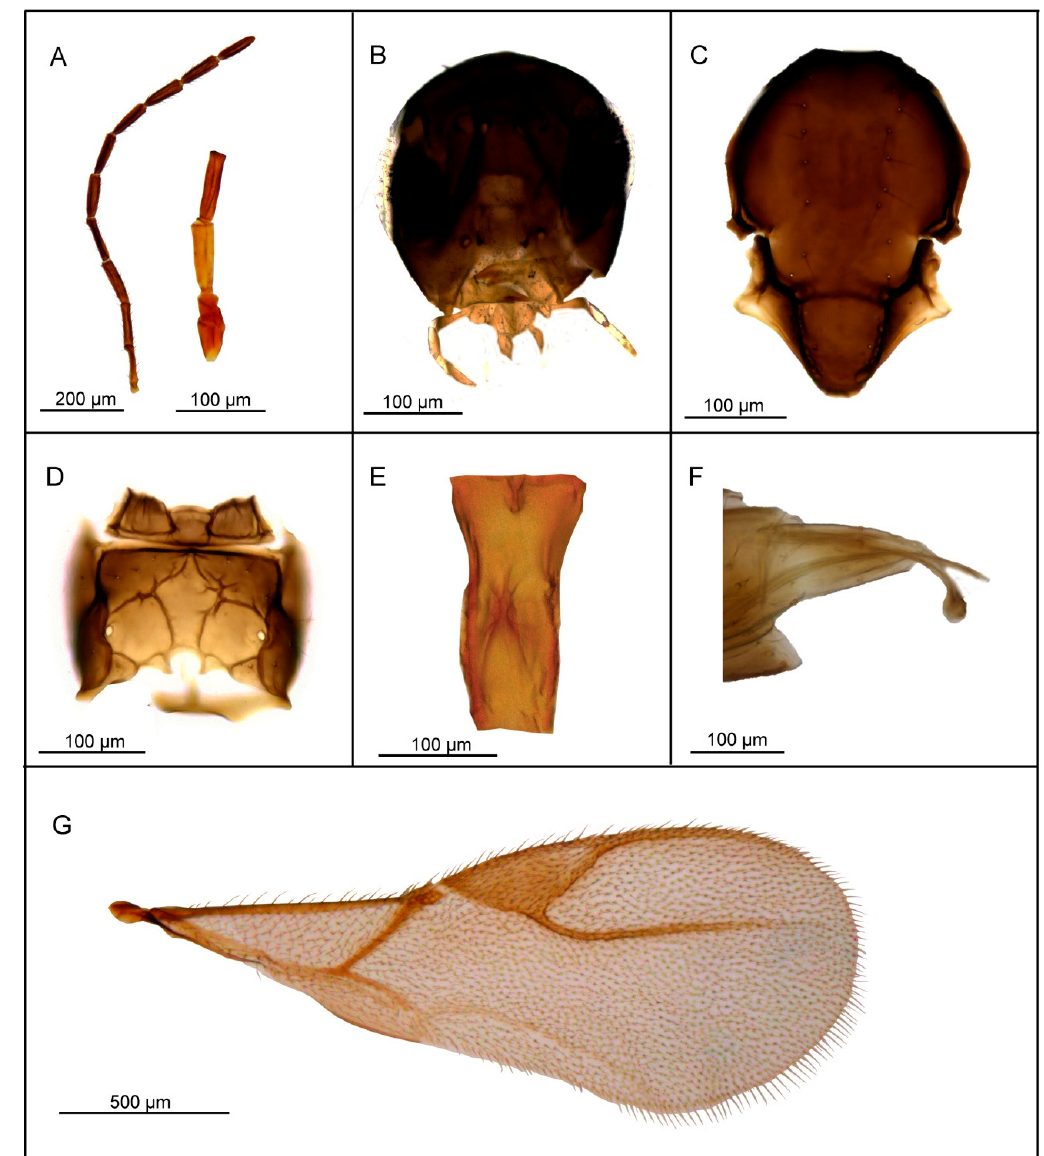
Figure 6. Lipolexis takadai sp. n. female: ( A ) antenna and F1 and F2; ( B ) head; ( C ) mesoscutum; ( D ) propodeum; ( E ) petiole, dorsal view; ( F ) ovipositor sheath; ( G ) forewing.